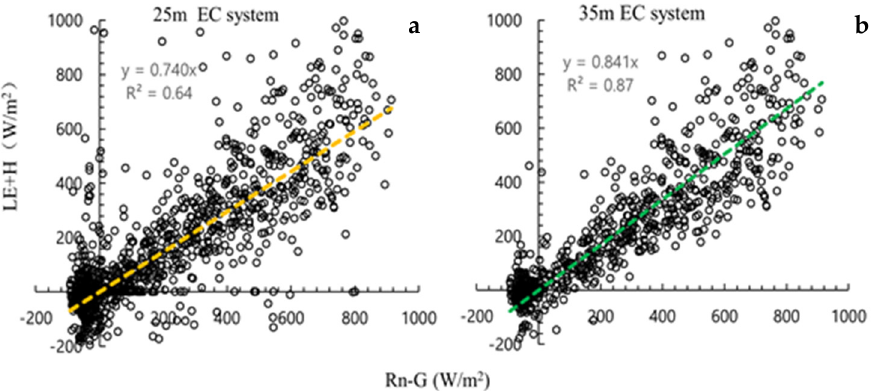
Figure 3. Energy balance closure of double − layer ( a ) 25m; ( b ) 35m EC system.